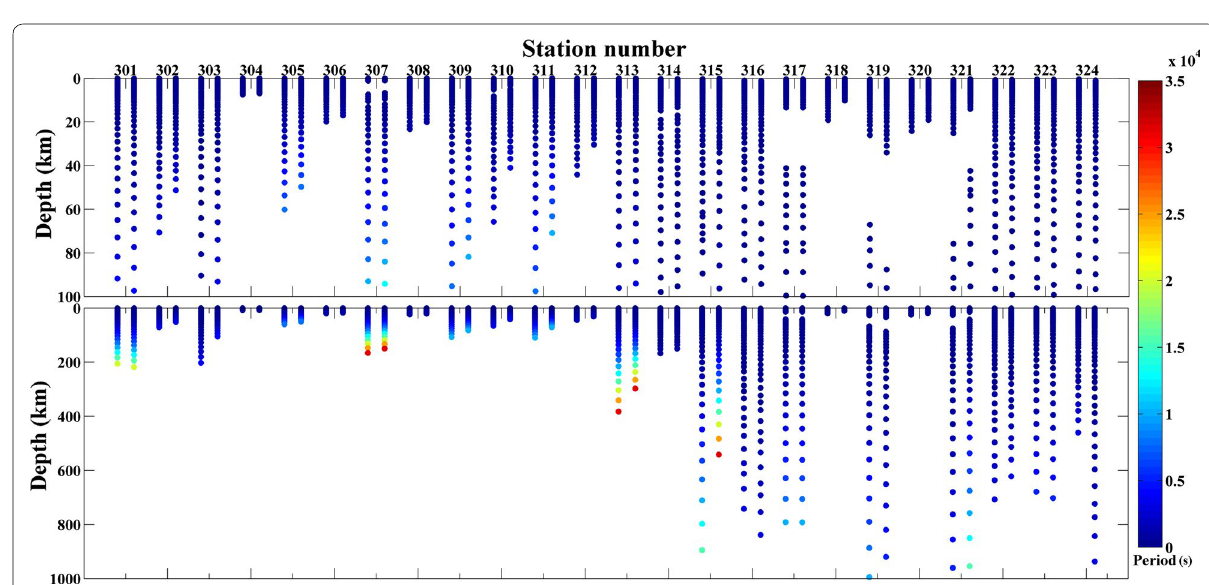
Fig. 5 Niblett-Bostick penetration depths for all sites on the profile. Each colored circle represents a measurement at a certain period and depth with the color indicating the period. The penetration depths are plotted separately for the TE mode (left column) and the TM mode (right column) of dots beneath each site. The depth ranges are 0–100 km (top panel) and 0–1000 km (bottom